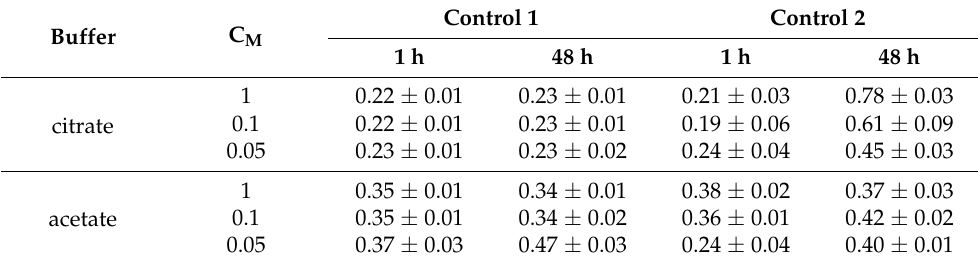
Table 1. Effect of buffer on A. niger cellulolytic activity (concentration of reducing substance,